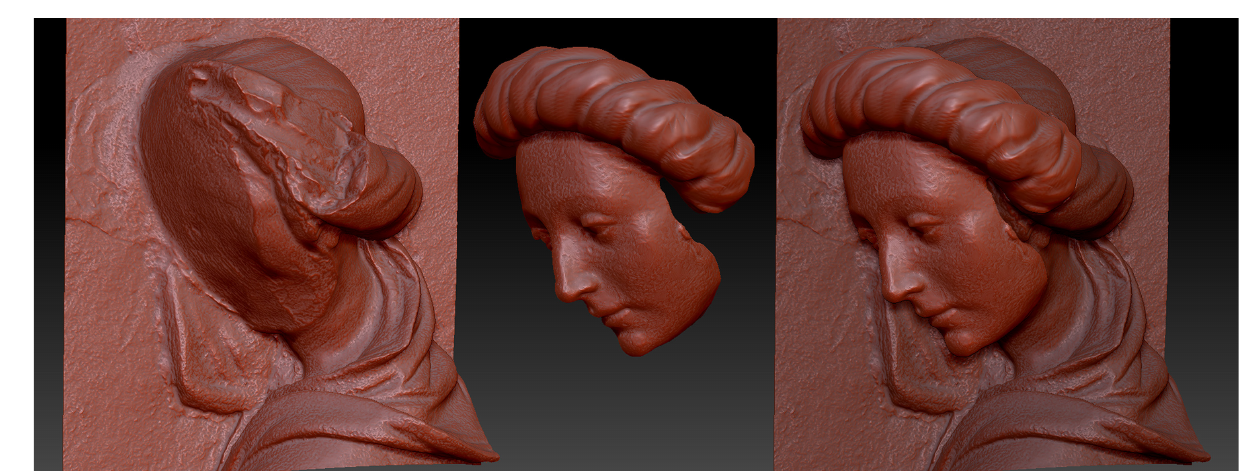
Table 2. Summary of the most relevant data of the project